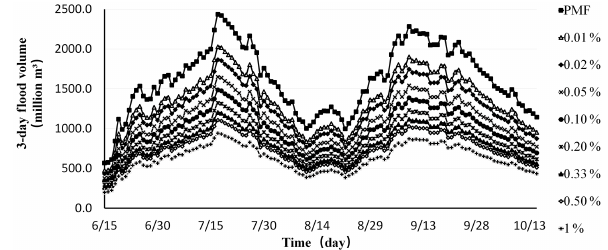
Figure 3. The change process of 3 day time-varying design flood volume at 9 kinds of design